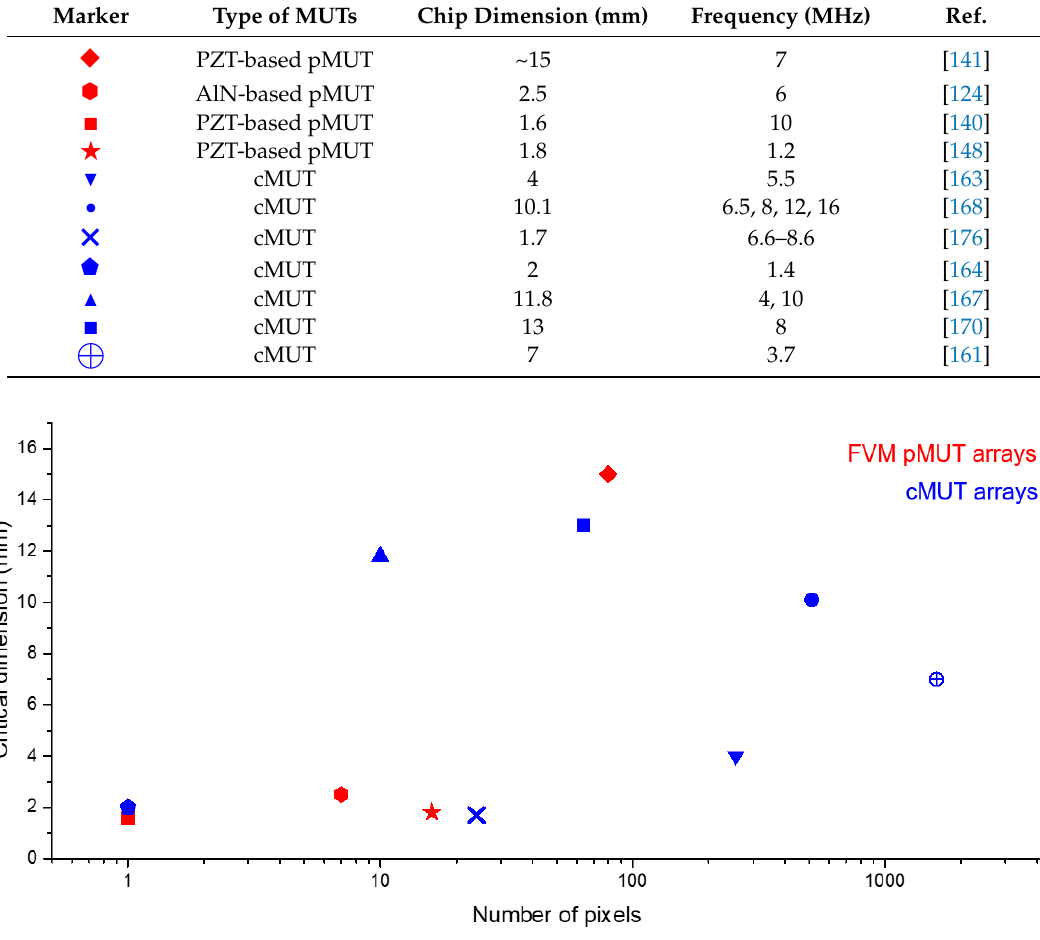
Figure 31. A comparison of FVM pMUT arrays and cMUT arrays for PAI applications (the markers are listed in Table 8).